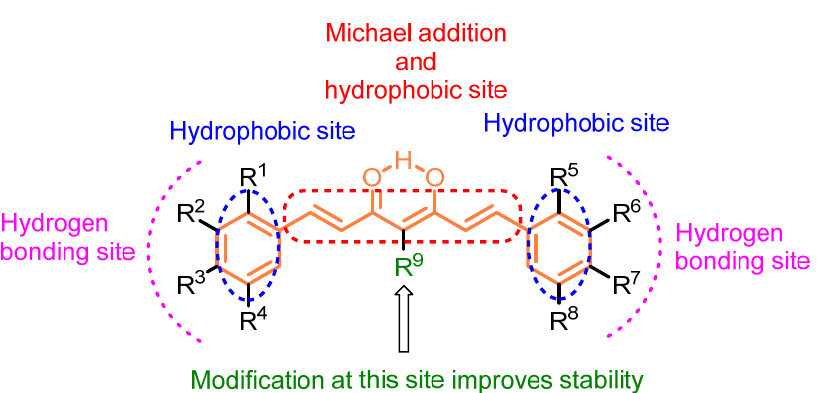
Figure 2. Structure of curcumin with indications of the important sites.